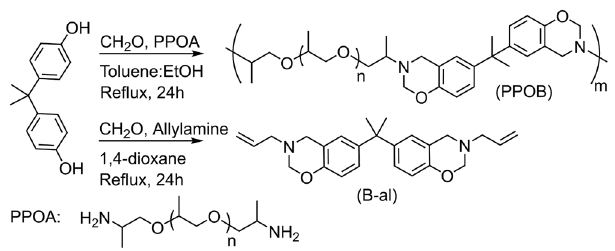
Figure 2. Synthesis of PPOB and B-al starting from bisphenol